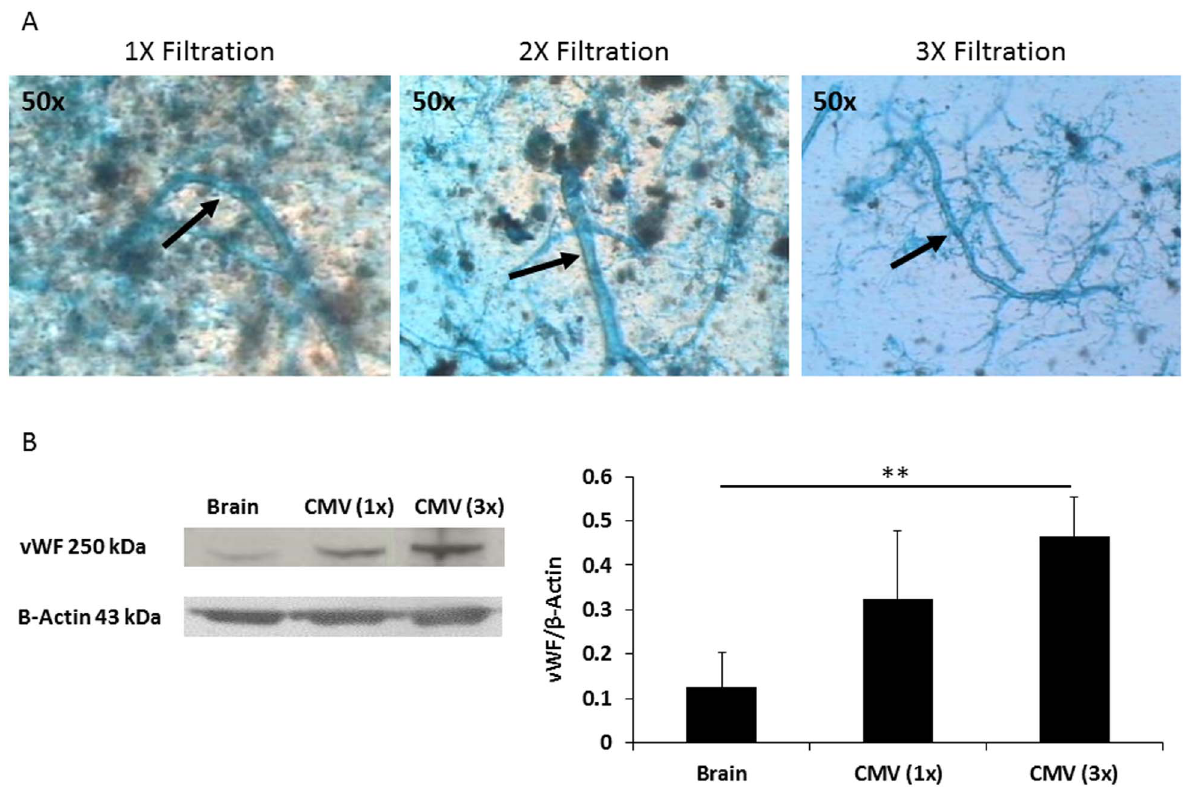
Figure 1. Filtration of cerebral microvessel samples improves purity. (A) Representative microscopy images (50 6 magnification) of suspended isolated cerebral microvessels stained with a 1% solution of Evans Blue in 0.9% NaCl. Arrows point to cerebral microvessels. Samples filtered three times through a 60- m m nylon mesh show substantially less cellular debris than those filtered one or two times. (B) Western blotting illustrates that the concentration of von Willebrand factor (vWF) protein increased significantly in samples filtered three times compared to samples filtered one time. Values of vWF expression are presented as a ratio to b -actin. All values are means 6 SD; ** p , 0.01 vs. homogenized brain or cerebral microvessel samples filtered one time. Western blot data are based on three independent gels, with n=3 per group.